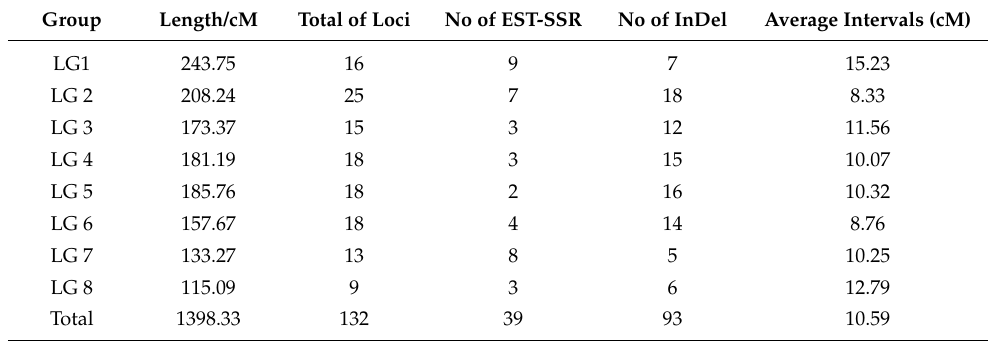
Table 3. Distribution of loci on the linkage maps from the F 1 population.